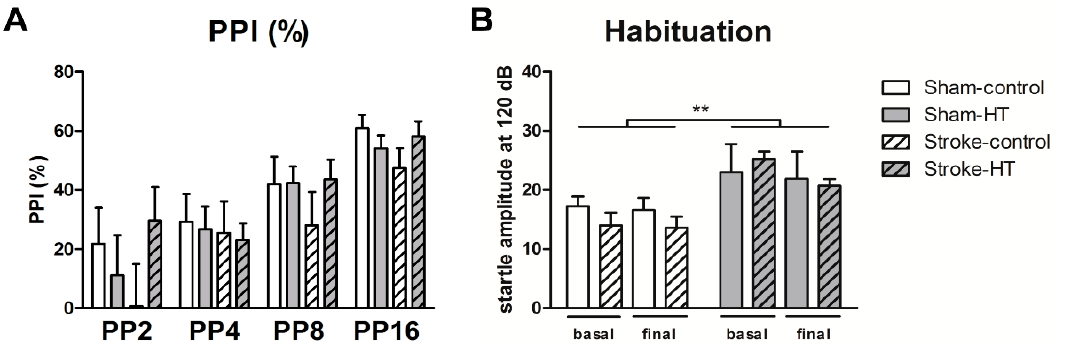
Figure 7. Sensorimotor integration measured before and after (16 days) stroke induction by the prepulse inhibition test (PPI). ( A ) PPI data shown as percentage. ( B ) Habituation to startle pulse. HT mice showed a higher startle amplitude to the basal and final startle stimulus of 120 dB than control mice ( p < 0.009). Values represent mean ± SEM. ** p < 0.01.